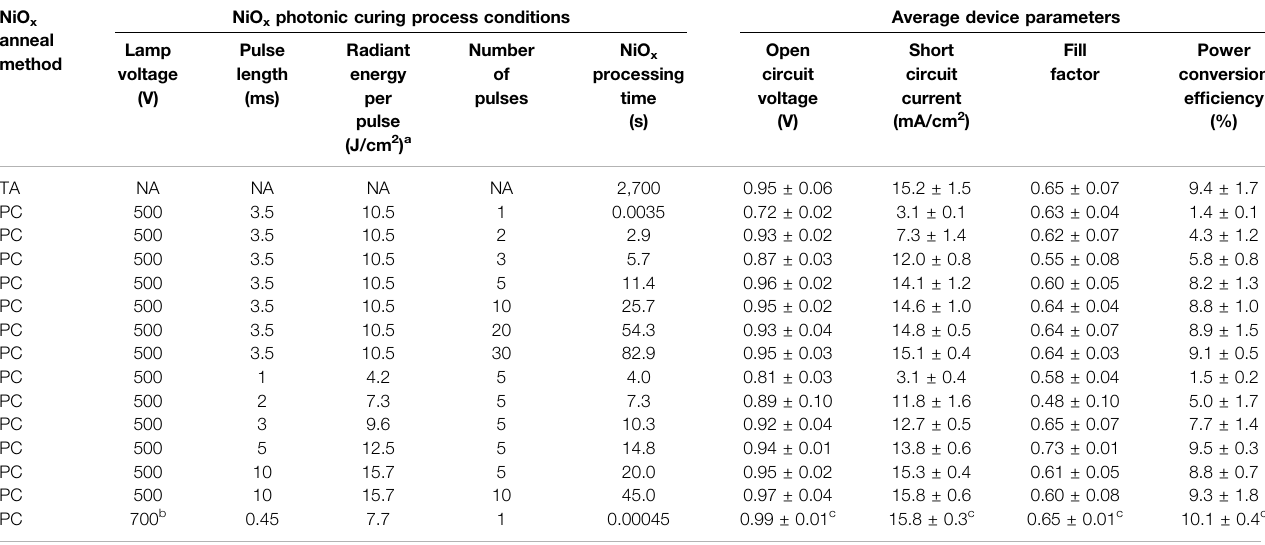
TABLE 1 | Average reverse-scan device J-V performance for PSCs made with PC NiO x + PC MAPbI 3 . NiO x anneal